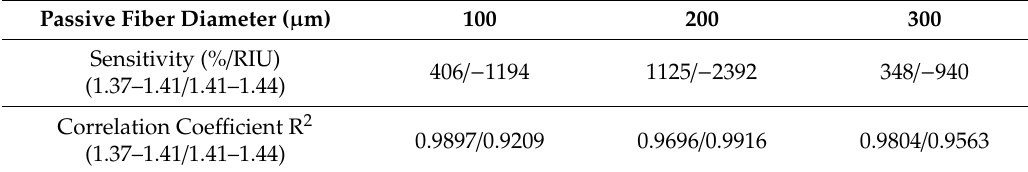
Figure 4. Refractive index (RI) sensing performances for the sensors with the active fiber diameter of 100 μ m, passive fiber diameters of 100, 200, and 300 μ m, respectively, and twisted region length of 12 mm. Table 1. The sensitivity results from Figure 4.